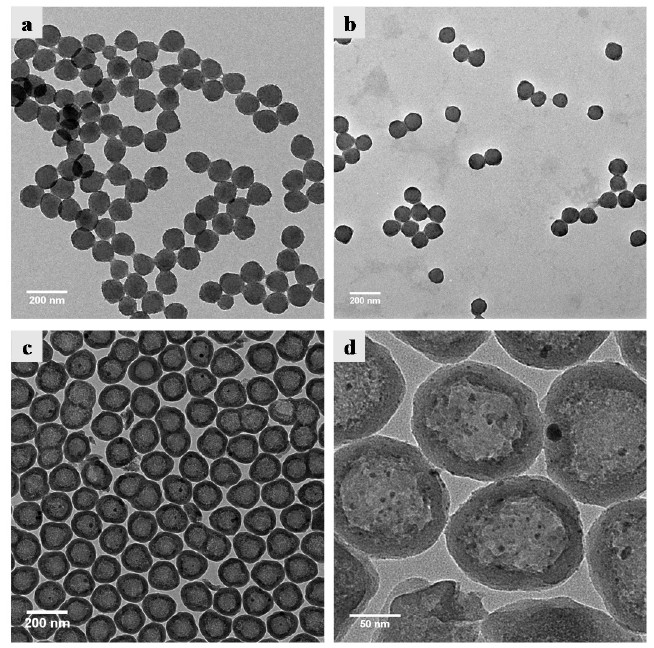
Figure 2. TEM images of ( a ) polystyrene (PS) core, ( b ) spherical polyelectrolyte brushes (SPB), ( c ) hollow Ag@SiO 2 and ( d ) enlarged hollow Ag@SiO 2 nanoparticles.